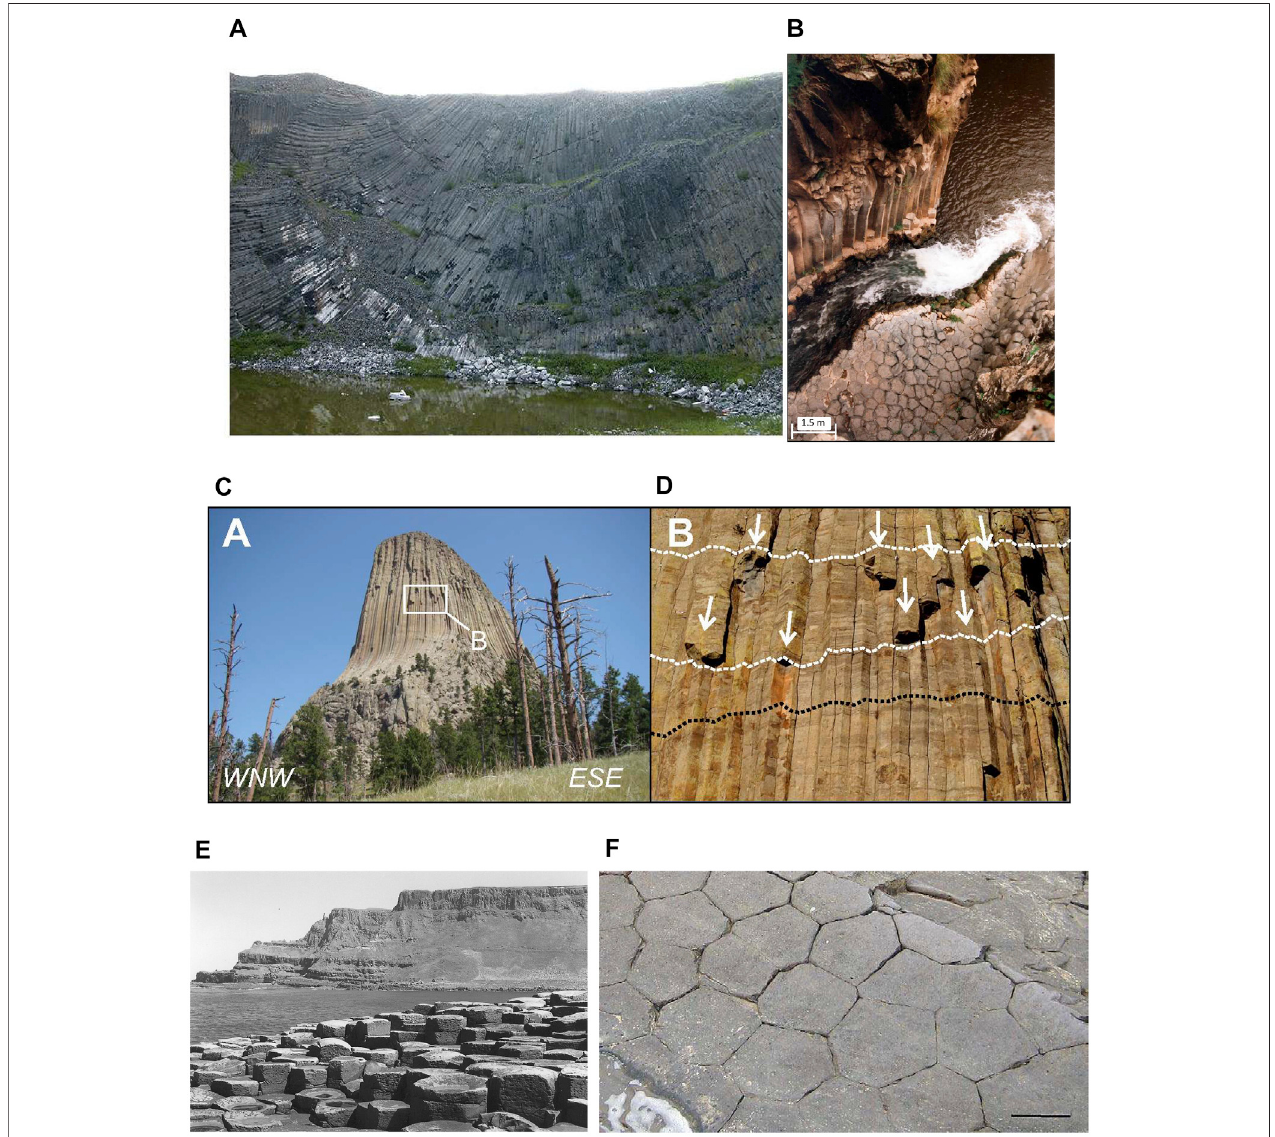
FIGURE 1 | Field photographs of the columnar jointed rock masses (CJRMs). (A) The CJRMs in Shandong, China (Xu 2010). (B) The CJRMs in Israel(Weinberger and Burg 2019). (C,D) The CJRMs ofthe Devils Tower in the United States (Zavada et al., 2015). (E) The CJRMs of the giant levee in Northern Ireland (Gilman 2009). (F) The CJRMs in France (Guy